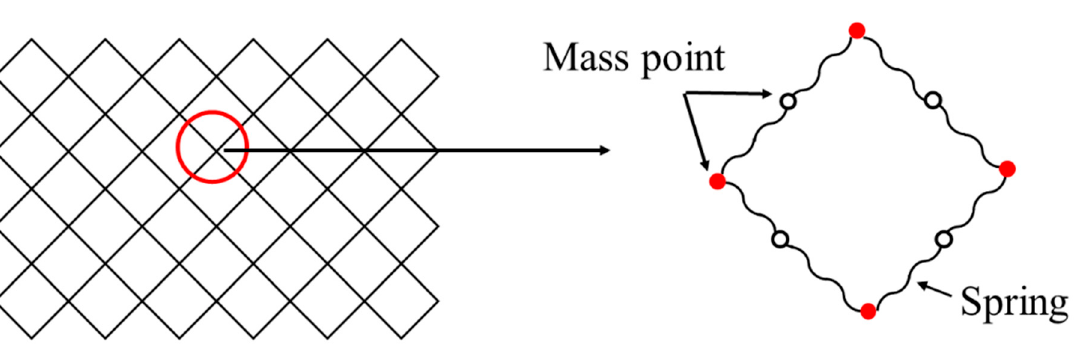
Figure 3. Mass-spring model for net.